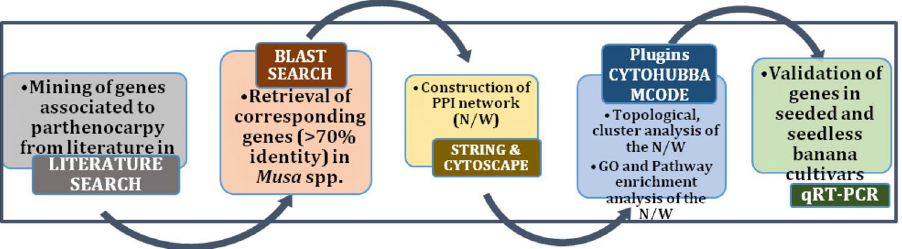
Figure 1. General workflow of the study. In 1st stage, genes associated with parthenocarpy were mined through literature search. In 2nd stage, corresponding orthologous genes in banana were retrieved using BLAST. In 3rd stage, PPI network was constructed using STRING and Cytoscape software. In 4th stage, topological, cluster analysis identified candidate genes and proposed putative pathway. In 5th stage, candidate genes were validated in Musa spp. through